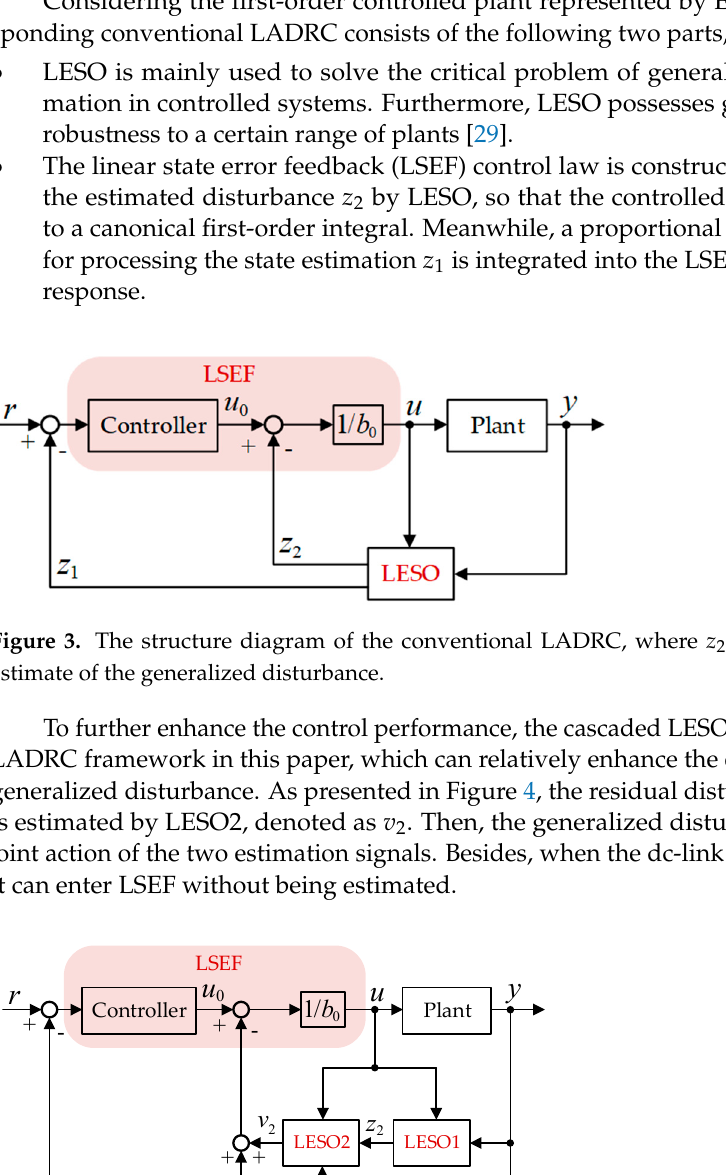
Figure 4. The structure diagram of the modified LADRC, where z 2 + v 2 is jointly responsible for estimating generalized disturbance.